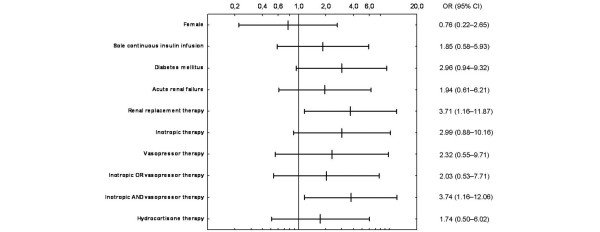
Odds ratio and 95% confidence intervals for different potential risk factors of hypoglycaemia. The following factors were not associated with an increased risk for hypoglycaemia: gender, age, type of admission (medical, scheduled surgical and unscheduled surgical), intensive insulin therapy (IIT) protocol, severity of illness (Simplified Acute Physiology Score (SAPS II) and Sepsis-Related Organ Failure Assessment (SOFA) scores at the first day of sepsis), acute renal failure (in contrast to continuous renal replacement therapy), vasopressor and hydrocortisone therapy, length of mechanical ventilation and length of stay.